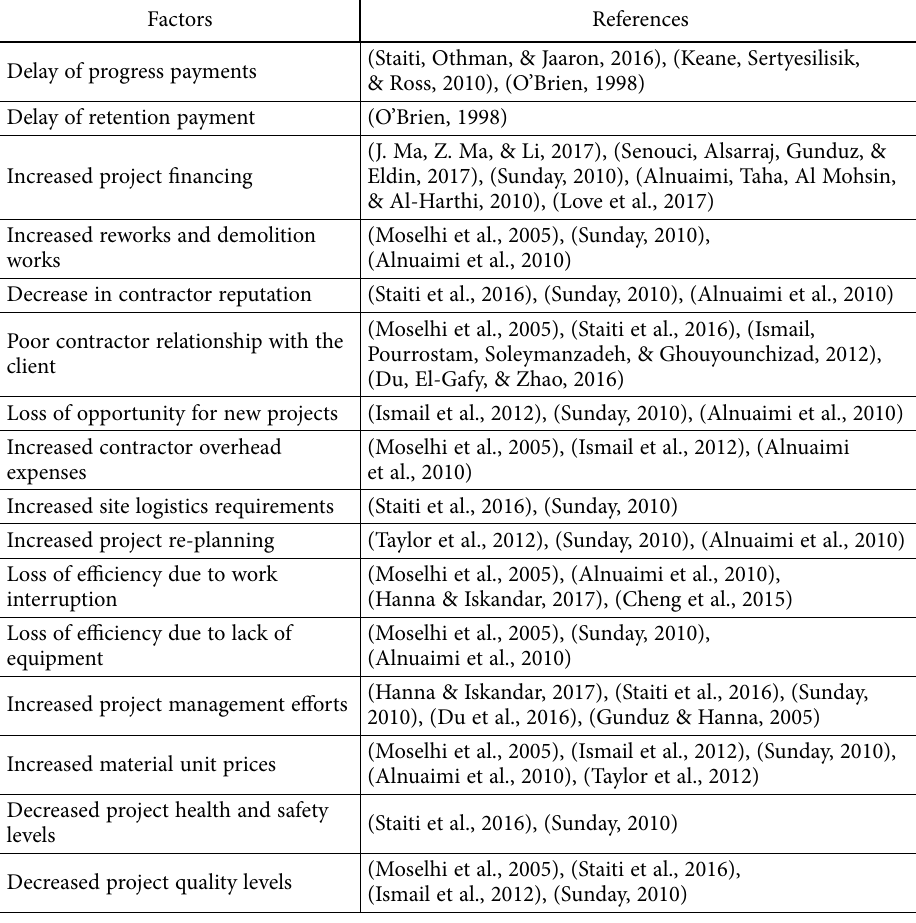
Table 1. Change orders impact